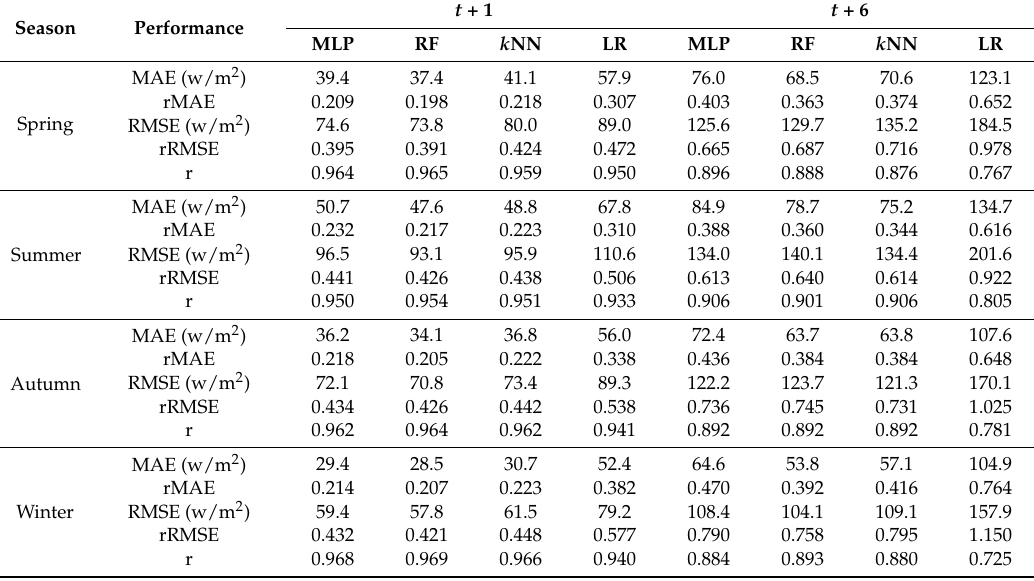
Table 4. Performance of all models within t + 1 and t + 6 across all seasons.